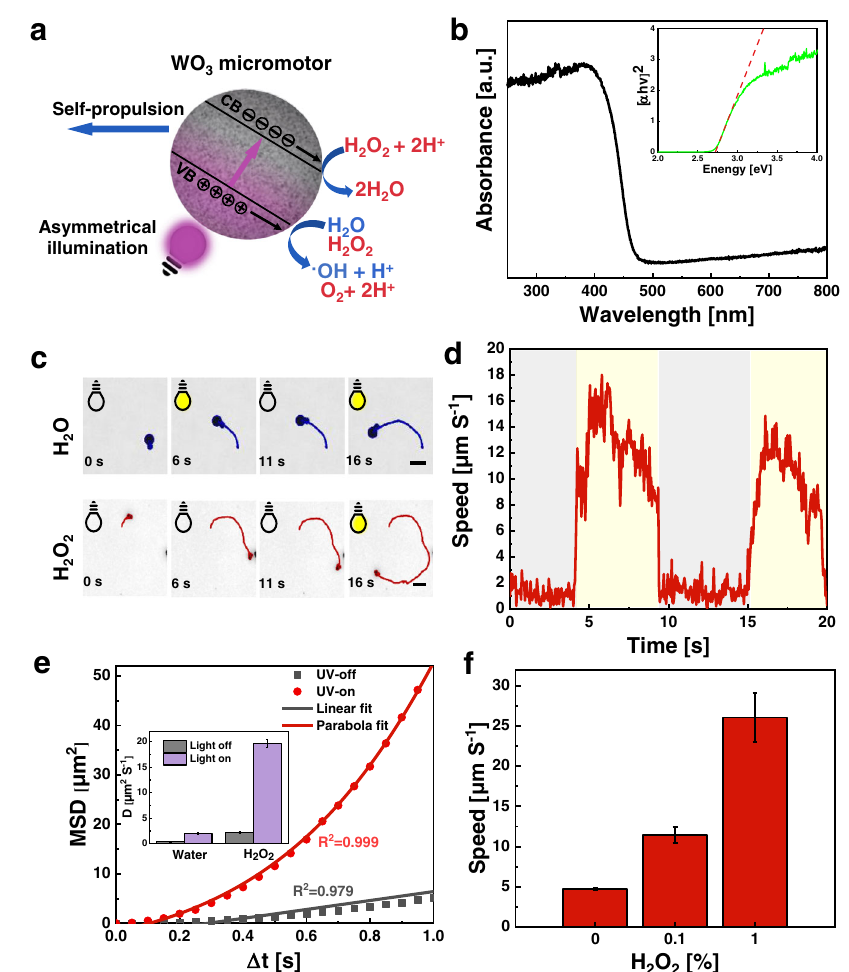
Fig. 2 Motion behavior of WO 3 micromotors. a Schematic illustration of the propulsion mechanism of light-powered WO 3 micromotors. b UV-Vis spectrum of WO 3 micromotors. The inset shows the bandgap estimation from the corresponding Tauc plot. c Time-lapse images of a WO 3 micromotor in 1% H 2 O 2 at intervals of ∼ 5 s. Scale bars are 5 µm. d Instantaneous speed values and e MSD plots of WO 3 micromotors in 1% H 2 O 2 without/with UV-light irradiation. The inset shows the corresponding diffusion coef fi cients according to MSD plots fi tting. f Comparison of micromotors ’ speed in different concentrations of H 2 O 2 . Error bars represent the standard deviation, n = 5 independent